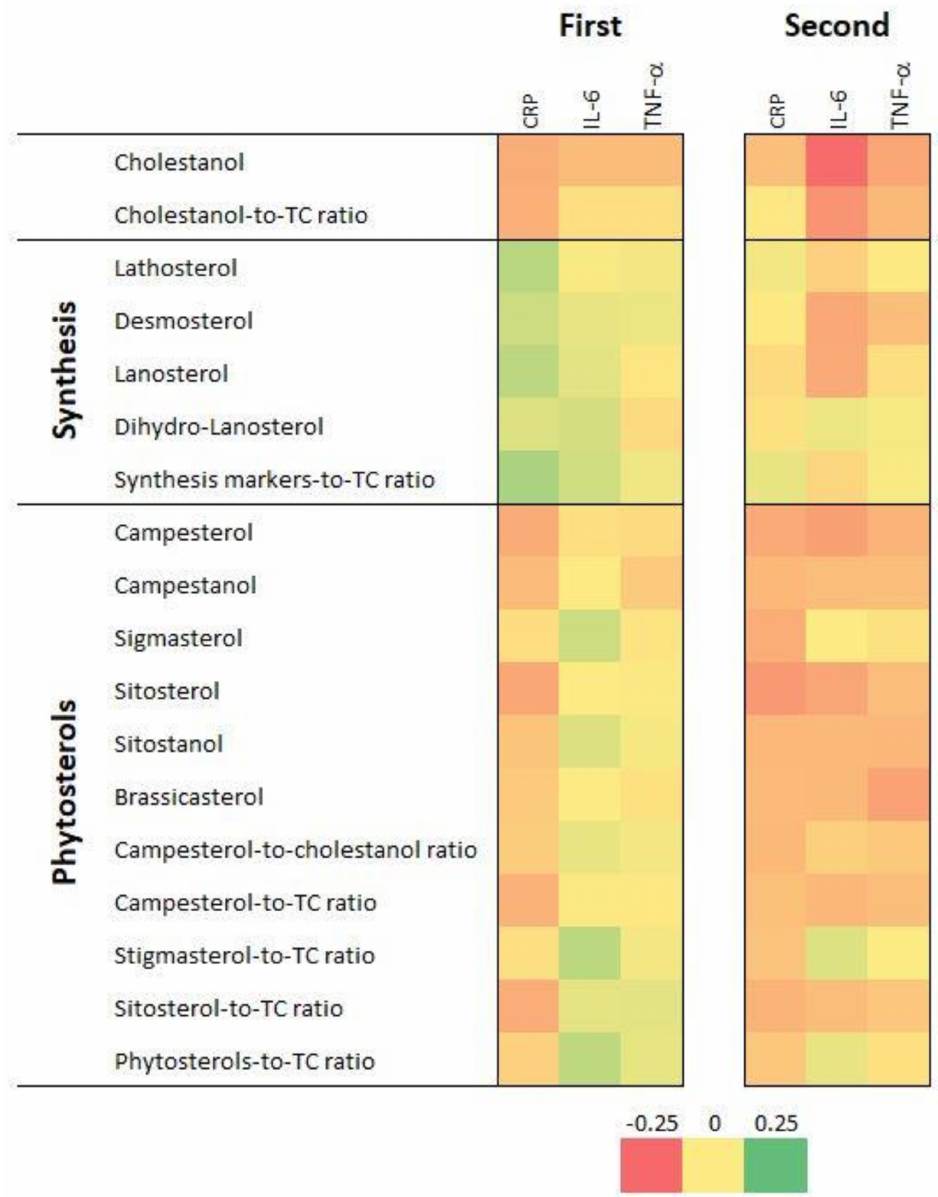
Figure 1. Bivariate correlation matrices between inflammatory markers and serum sterol levels and ratios, first (2009–2012) and second (2014–2017) follow-up, CoLaus|PsyCoLaus study, Lausanne, Switzerland. CRP, C-reactive protein; IL-6, interleukin 6; TNF- α , tumor necrosis factor alpha; TC, total cholesterol. Results for the first follow-up are in the first rectangle and for the second follow-up, in the second rectangle. Associations are represented on a color scale, going from red (strongly negative coefficients) to green (strongly positive coefficients), with coefficient values close to zero represented in